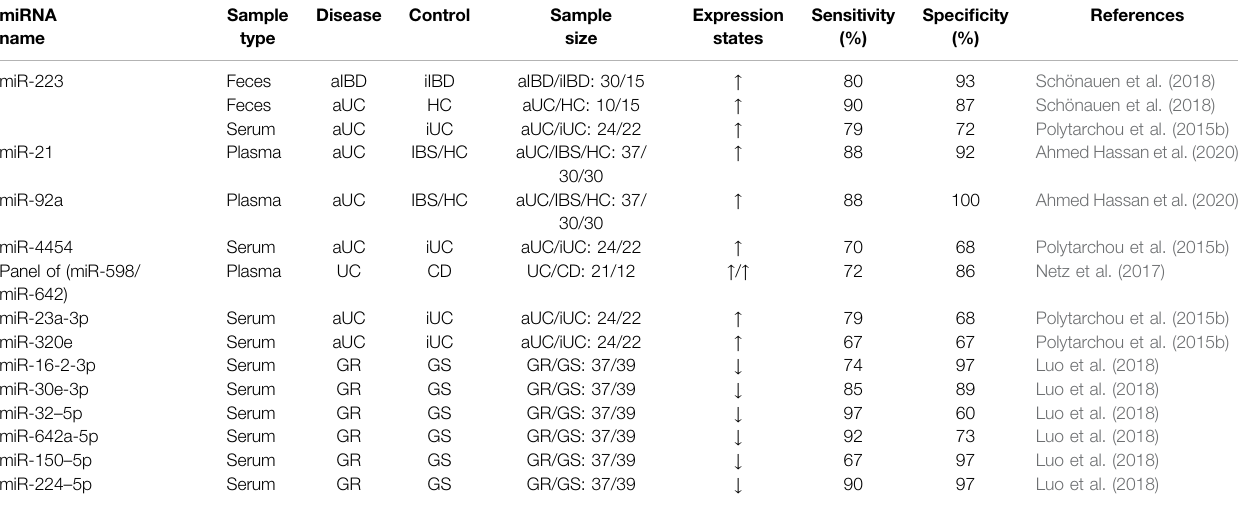
TABLE 3 | miRNAs levels of UC patients in different studies. miRNA